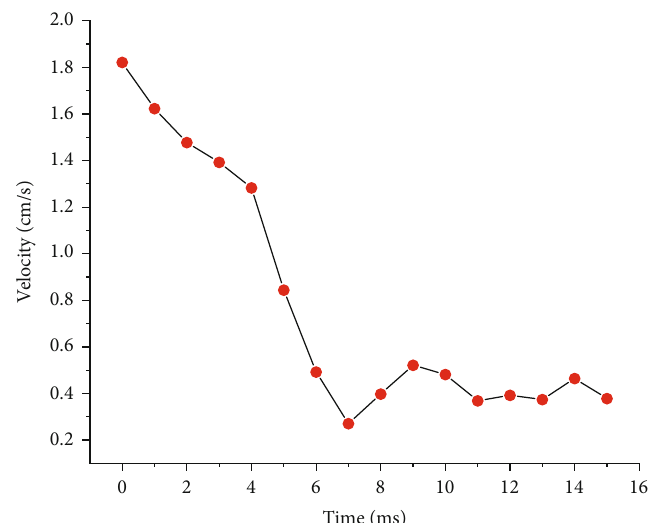
Figure 8: Positive peak vibration velocity diagram after superposition of di ff erent micro-di ff erence waveforms.